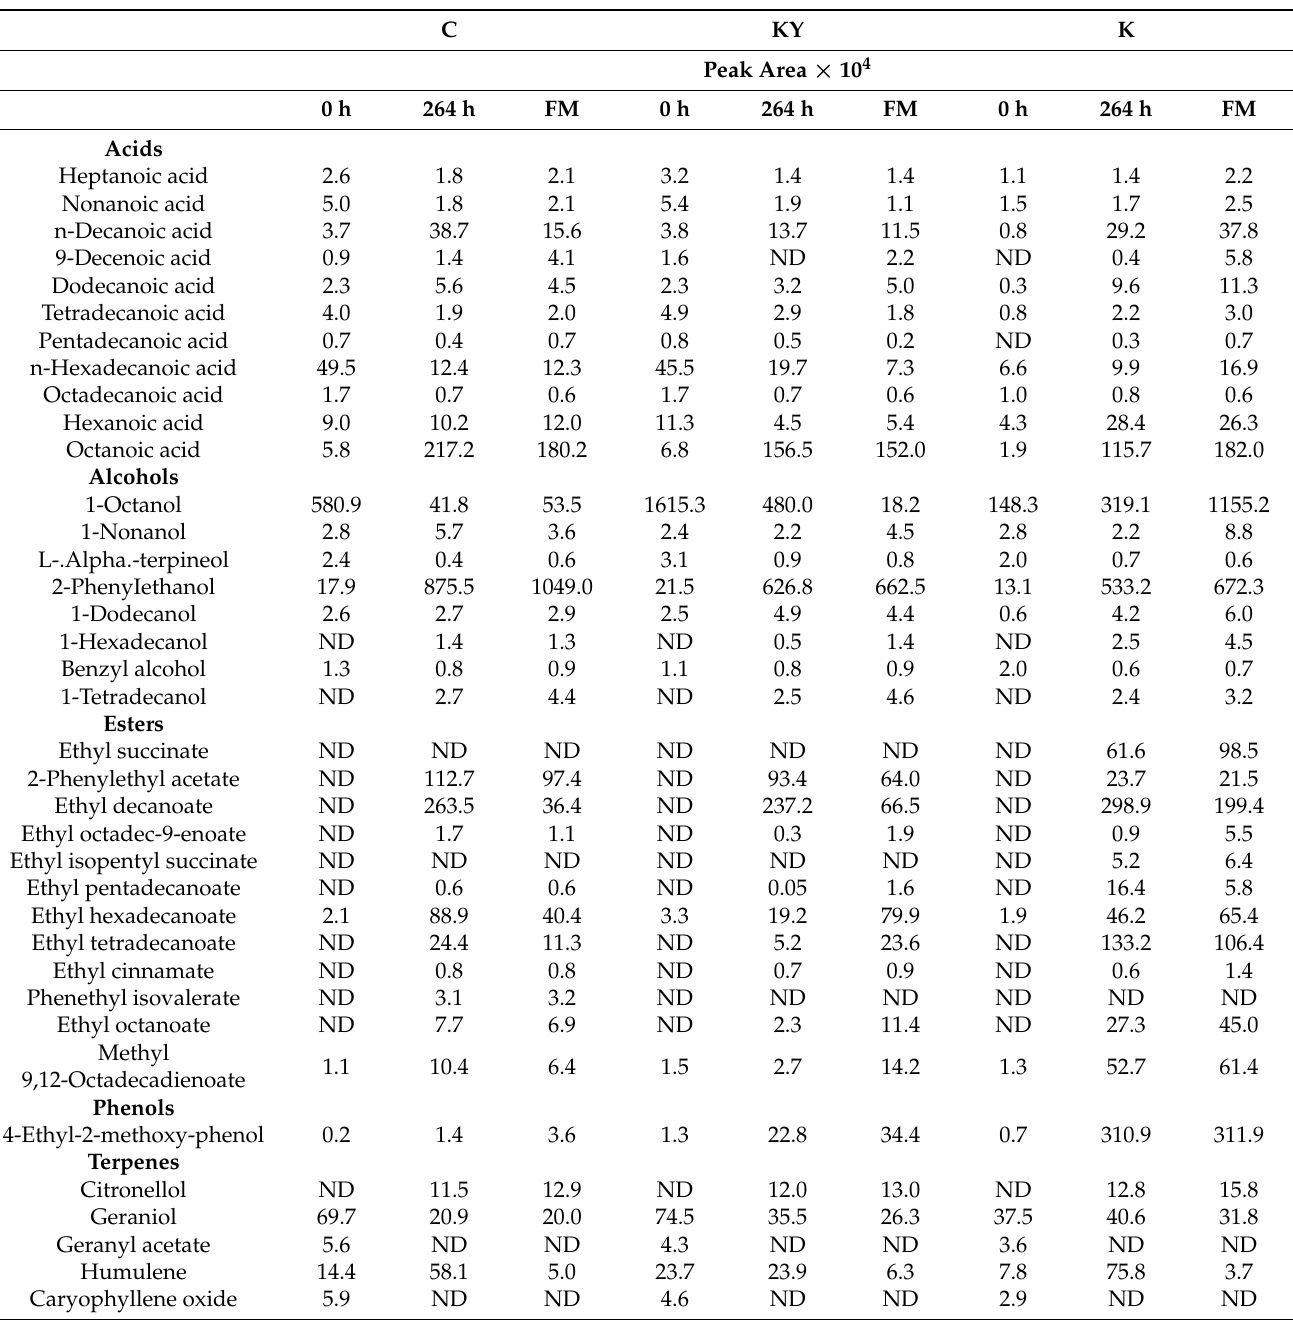
Table 3. Volatile compounds (peak area × 10 4 ) detected at 0 h and 264 h of fermentation and after 10 days of maturation for beers produced in the assays inoculated with commercial yeast (C), kombucha and commercial yeast (KY) and kombucha